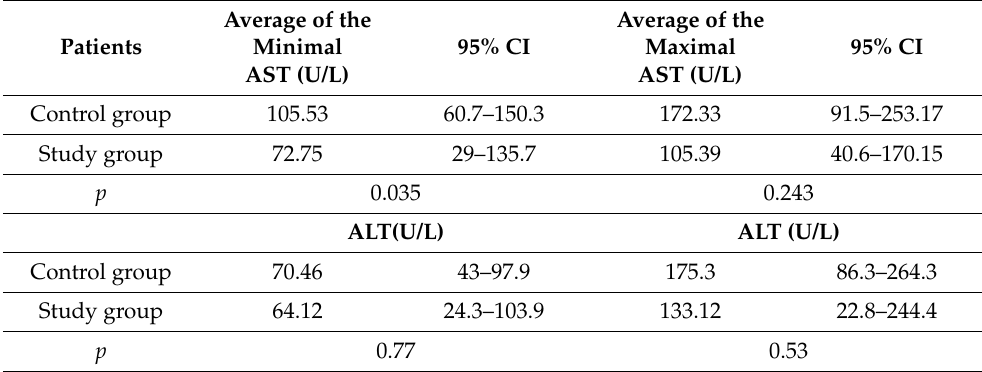
Table 3. Variability of the minimal and maximal AST and ALT levels between